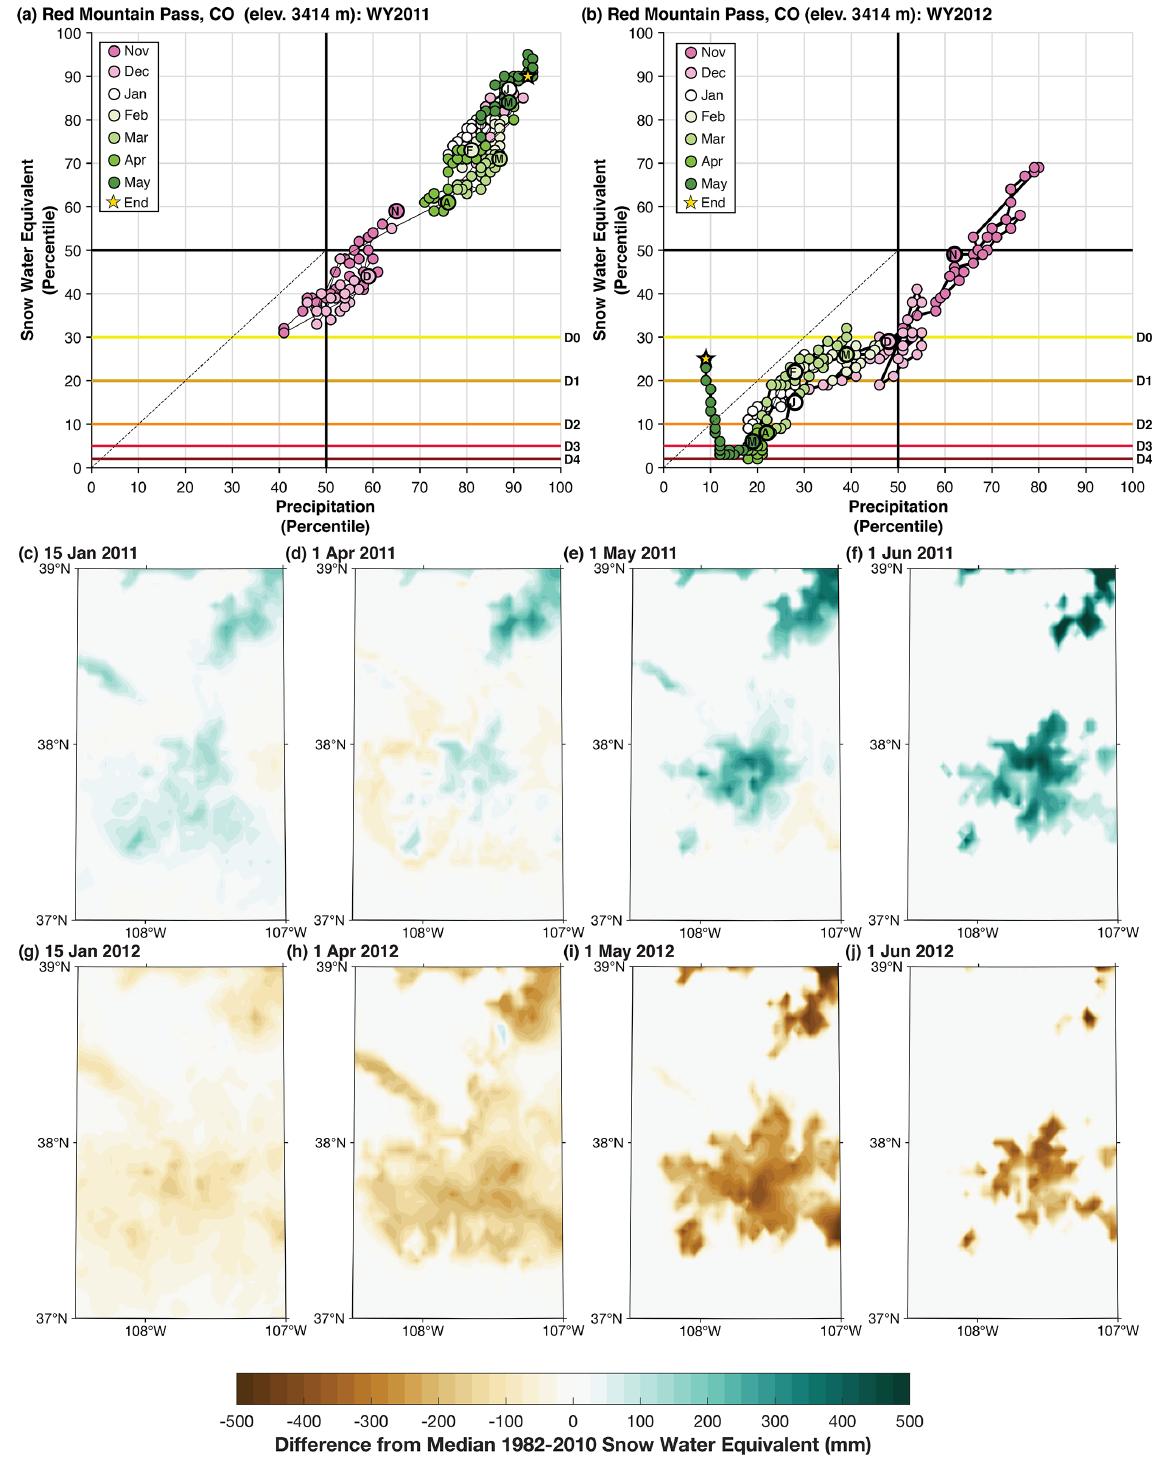
Figure 5. Comparison of an anomalously snowy and wet “big year” (a) and anomalously dry year (b) in the San Juan Mountains at Red Mountain, Colorado, during water years (WY) 2011 and 2012, respectively. (c–f) Spatial snow water equivalent anomalies (in millimeters) during WY 2011 for midwinter and early, middle, and late spring from the UAswe product (Zeng et al., 2018). (g–j) As in (c) – (f) but for WY